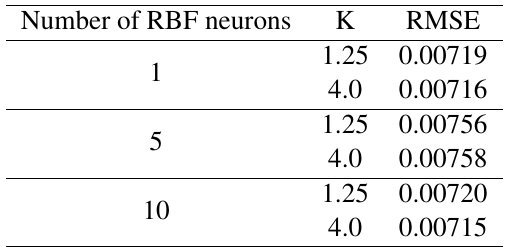
Table 3. Ex post forecast RMSEs for various granular RBF NNs (see text for